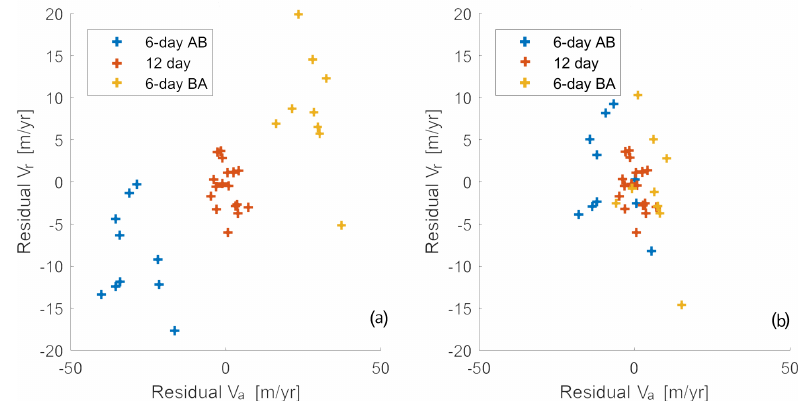
Figure 6. Scatter plot of IW1 average residual range ( v r ) and azimuth ( v a ) velocity error of 37 Sentinel-1 pairs: (a) without calibration and (b) calibrated with constants from Gisinger et al.